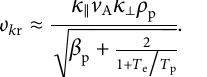
FIGURE 7 | Schematic illustration of the quasi-linear diffusion in the Langmuir instability and the electron-beam instability. The blue shaded area represents the core electron population with bulk velocity U c , and the red shaded area represents the strahl population with bulk velocity U s . The black semi-circles represent Eq. 17 for either wave type with parallel phase speed v ph . The diffusive fl ux of Landau-resonant particles is shown by the red arrow. The green-dashed semi-circle indicates v 2 ⊥ + v 2 (cid:2) (cid:3)